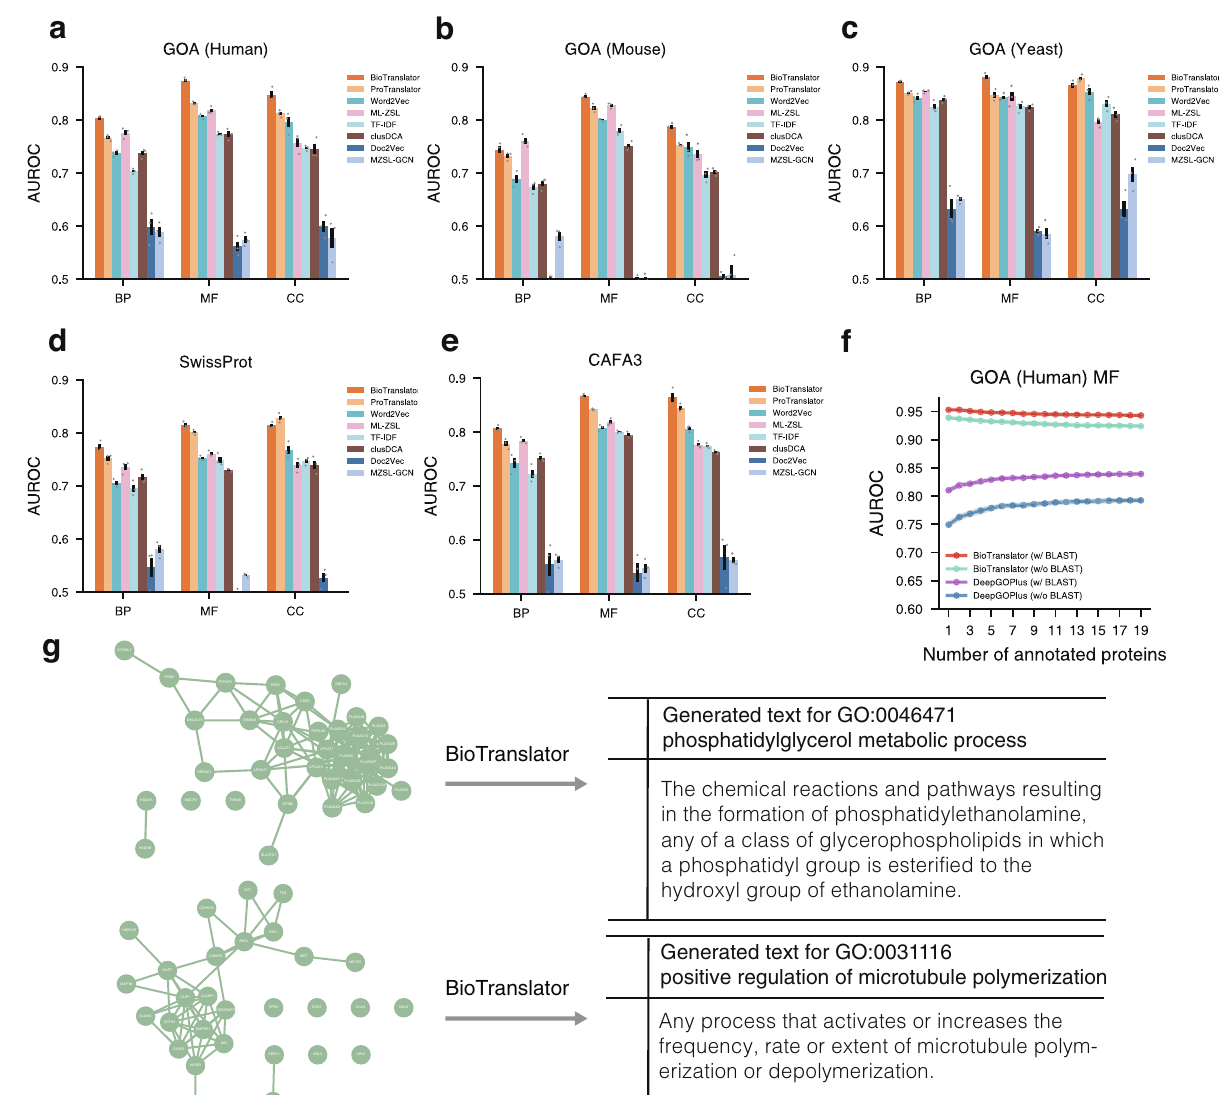
Fig. 2 | Performance of BioTranslator on annotating novel protein functions. a – e Bar Plots showing the AUROC of BioTranslator, ProTranslator, TF-IDF, Word2vec, Doc2vec, ML-ZSL, MZSL-GCN, and clusDCA on GOA (Human), GOA (Mouse), GOA (Yeast), SwissProt, and CAFA3. All proteins annotated by test functions were excluded. BP biological process, MF molecular function, CC cel- lular component. Error bar represents standard errors across 3-fold cross-vali- dation and its center is mean value. f Plot comparing the AUROC of using BioTranslator (w/ BLAST), BioTranslator (w/o BLAST), DeepGOPlus (w/ BLAST),